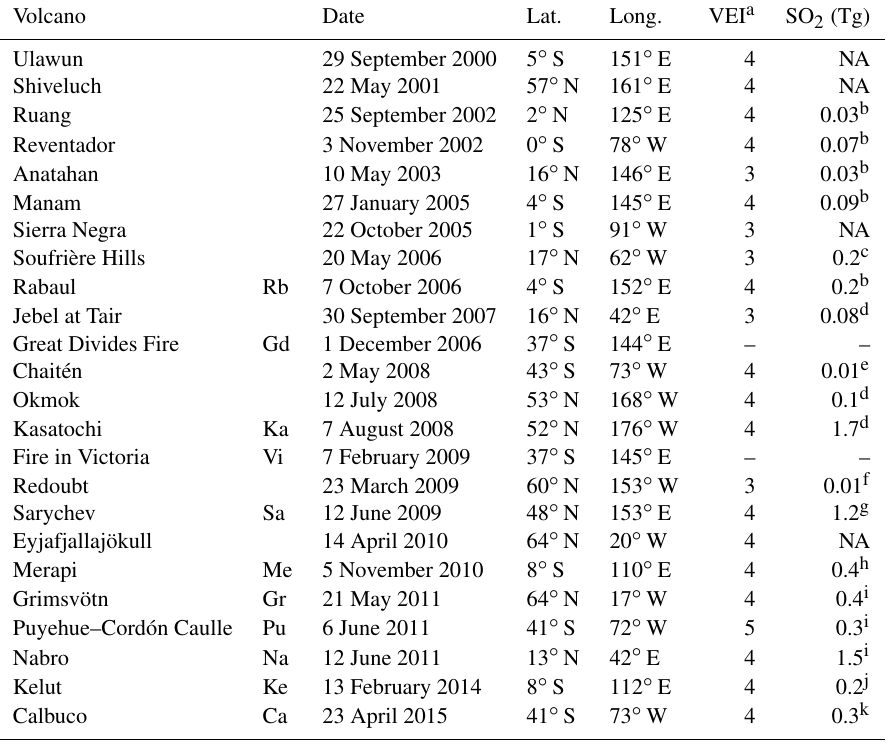
Table 1. Volcanic eruptions and wildfires in the 21st century that affect (or had the potential to affect) the aerosol loading of the stratosphere. NA is not available. Volcano Date Lat.